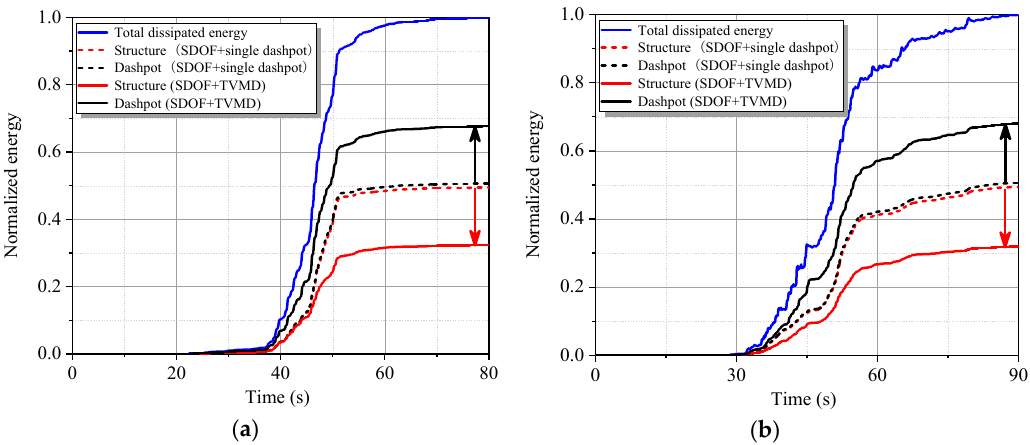
Figure 19. Energy response results of designed SDOF elements. ( a ) Energy responses under the excitation of TAP077. ( b ) Energy responses under the excitation of CHY102.